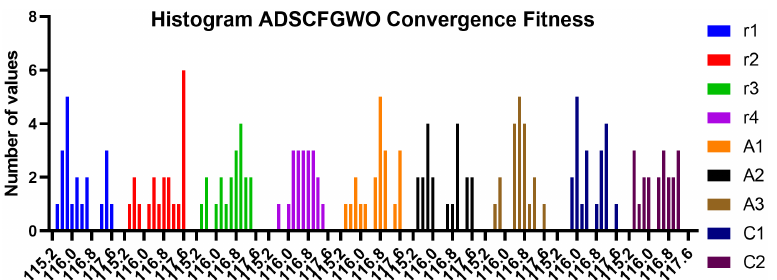
Figure 13. Histogram of convergence fitness of ADSCFGWO’s parameters ( r 1 , r 2 , r 3 , r 4 , A 1 , A 2 , A 3 , C 1 , and C 2